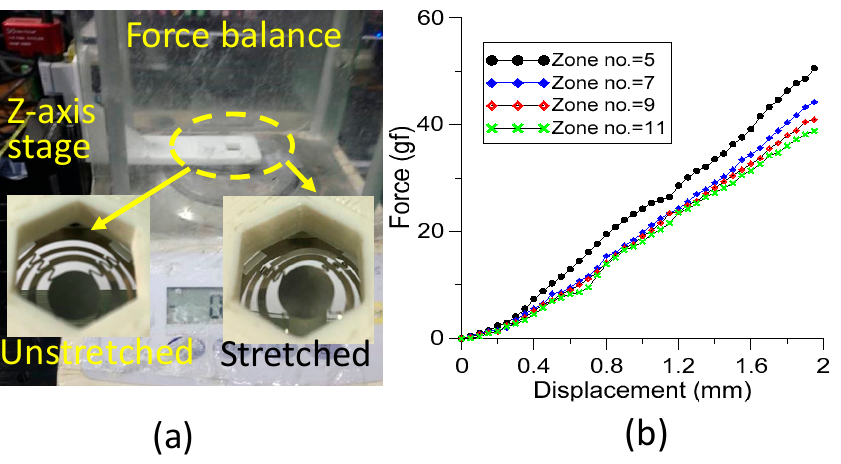
Figure 7. ( a ) Experimental setup for characterizing the stretchable zone plate. ( b ) The stretched displacement in the out-of-plane direction of the zone plate as a function of applied forces.